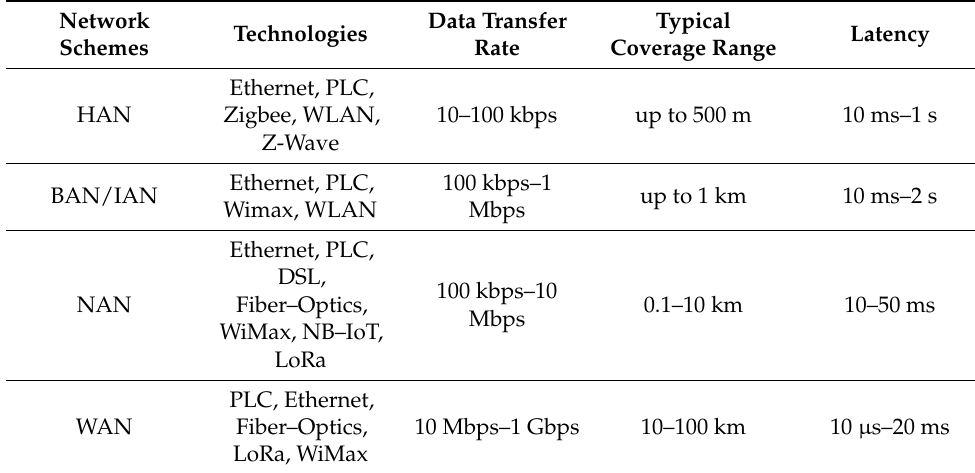
Table 1. Network schemes and communication technologies